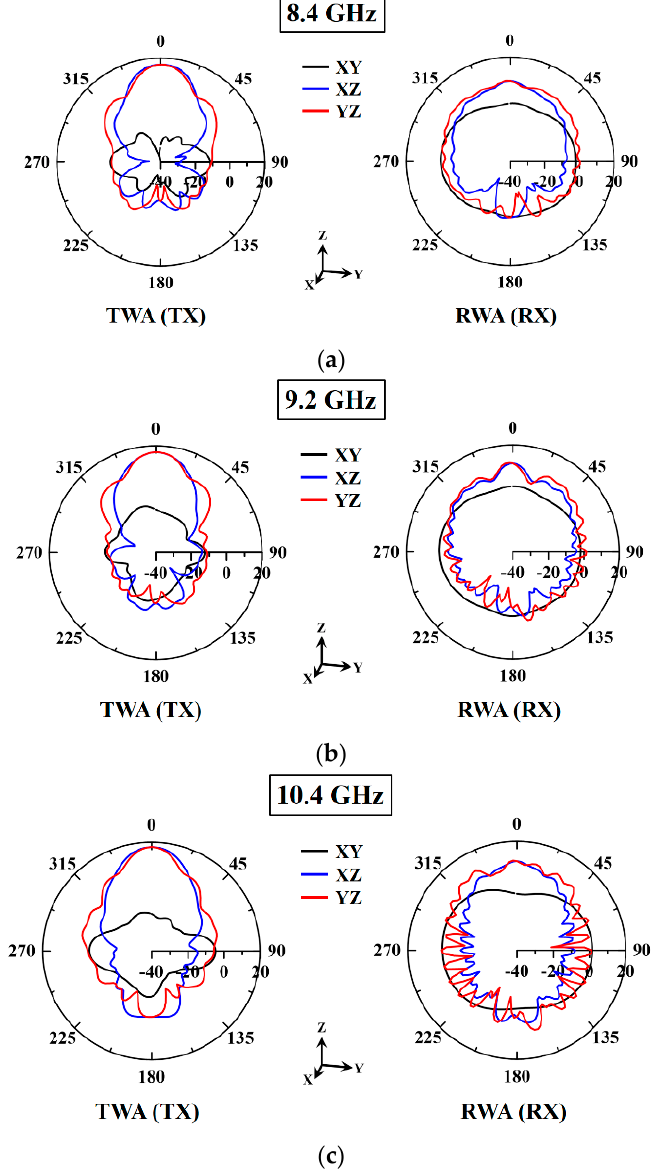
Figure 4. Measured two-dimensional radiation pattern on the X–Y, X–Z, and Y–Z planes of the transmitting and receiving waveguide antennas at scanning frequencies of ( a ) 8.4 GHz, ( b ) 9.2 GHz, and ( c ) 10.4 GHz.